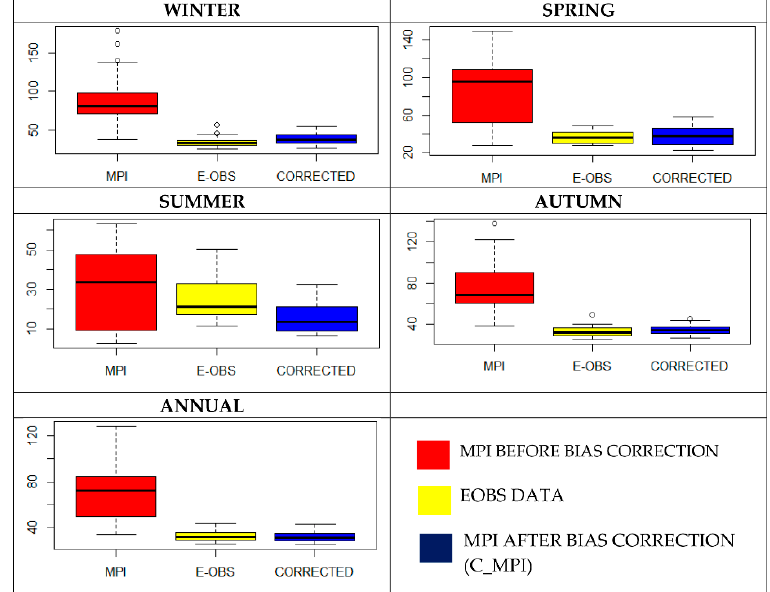
Figure 7. Boxplots of the three studied datasets for the four seasons and for the whole studied period